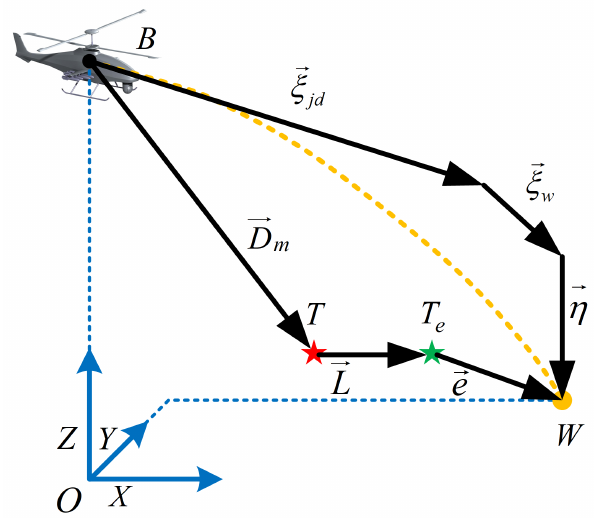
Figure 2. The schematic diagram of the fire-control command calculation